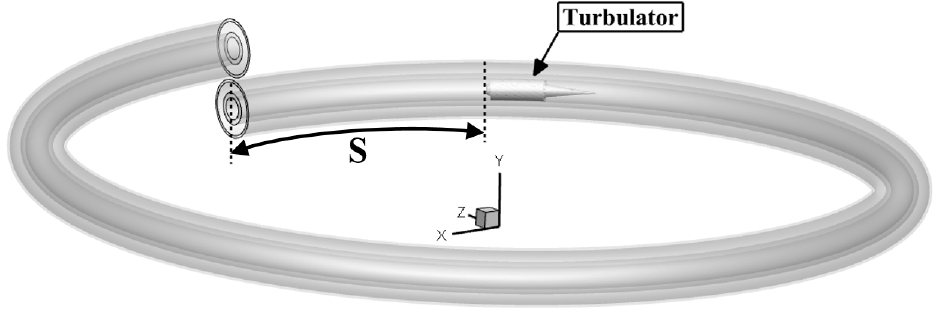
Figure 13. The definition of swirl generator position parameter (S).